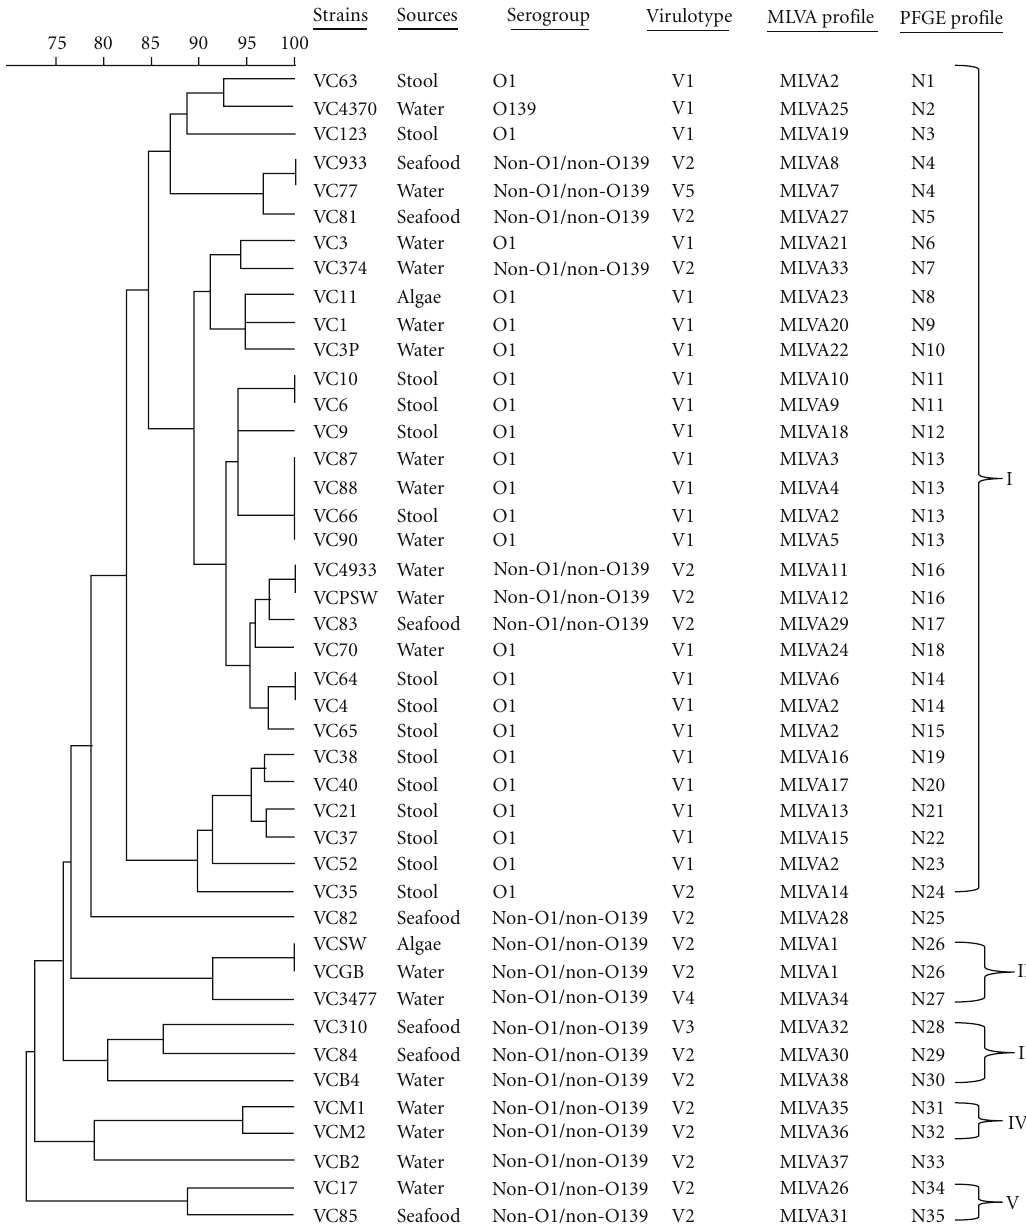
Figure 3: Dendrogram generated using PFGE profiles showing the relatedness of 43 Malaysian V. cholerae with virulotypes and MLVA profiles. The dendrogram is based on the unweighted pair group method with arithmetic averages (UPGMA) using the position tolerance of 0.15. Five clusters were observed at the similarity of 80% with all O1 strains clustered in Cluster I. V1 : ctx A + , zot + , rtx A + , rst R + , tox R + , tcp A E+ , tcp I + , and hly A E+ ; V2 : rtx A + , rst R + , tox R + , and hly A E+ ; V3 : rtx A + , rst R + , tox R + , tcp I + , and hly A E+ ; V4: rtx A + , rst R + , tox R + , tcp I + , and hly A C+ ; V5: rtx A + , rst R + , tox R + , and hly A C+